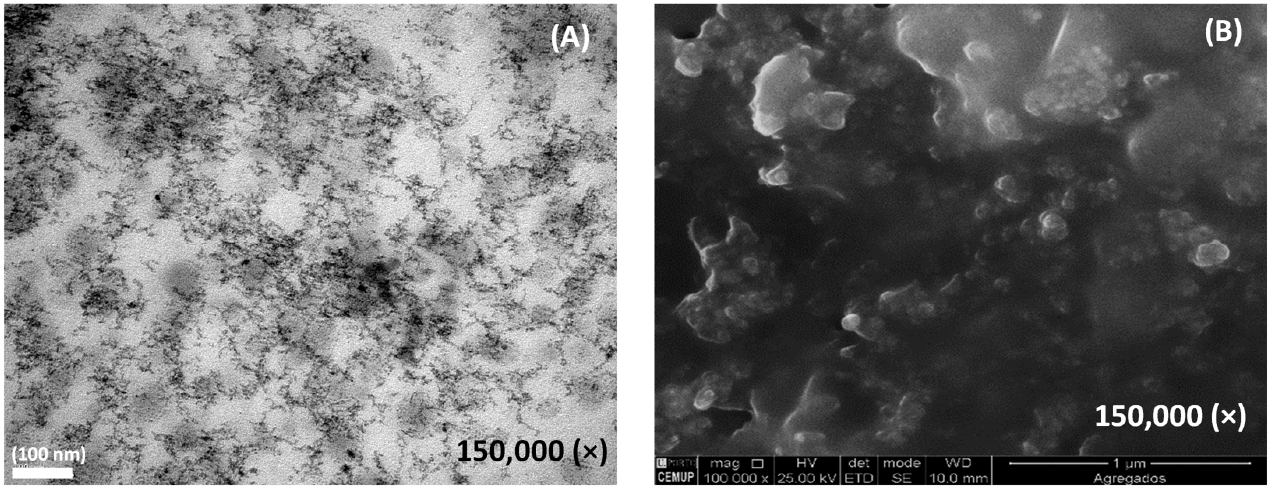
Figure 3. ( A ) TEM images of red-emitting CdTe@MPA QDs resuspended in ultrapure water; ( B